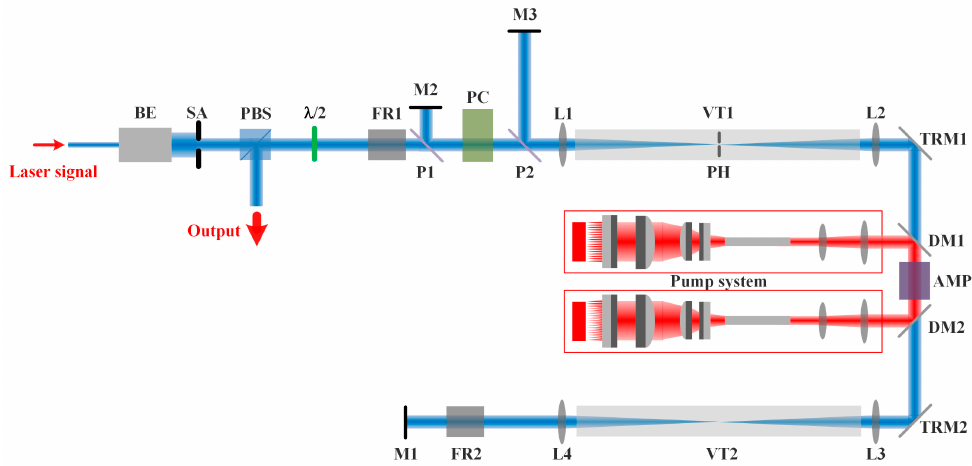
Figure 1. LD end-pumped Nd:glass multi-pass laser amplifier system. BE: beam expander; SA: serrated aperture; PBS: polarization beam splitter; λ /2: half-wave plate; FR1 and FR2: Faraday rotators; PC: Pockels cell; P1 and P2: thin-film polarizers; M1, M2, and M3: end mirrors; L1, L2, L3, and L4: convex lenses with f = 750 mm; TRM1 and TRM2: totally reflective mirrors; DM1 and DM2: dichroic mirrors; VT1 and VT2: vacuum tubes; PH: pinhole plate; AMP: bonded Nd:glass amplifier head.